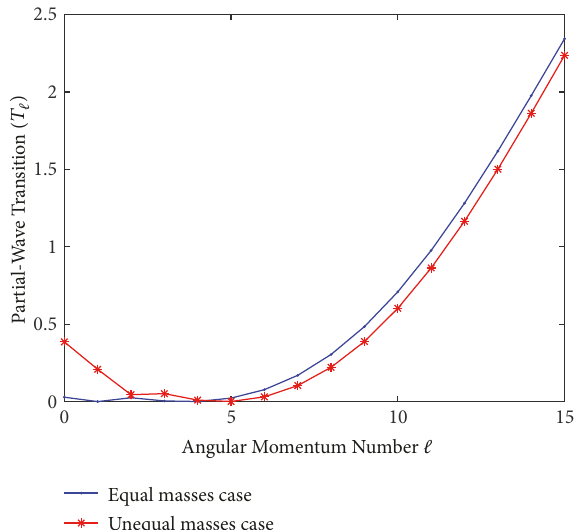
Figure 3:Partial-wave transition for the spinless Salpeterequation with the Hellmann potentialas a functionof angular momentumquantum number 𝑙 with 𝑎 = 0,𝑏 = −3 , 𝐸 𝑛,𝑙 = 1,𝜌 = 0.5